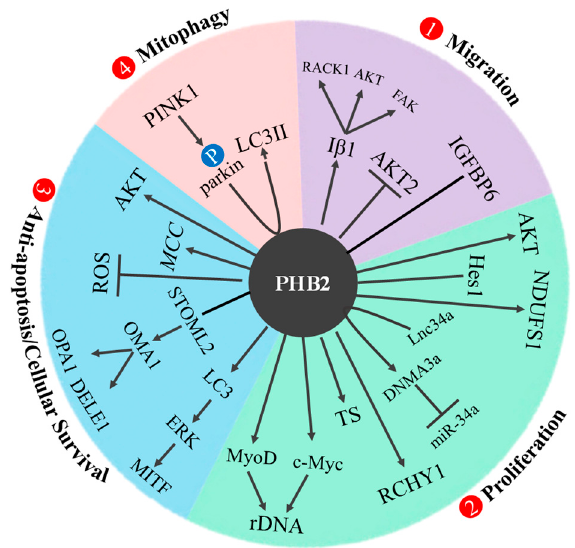
Figure 5. Schematic diagram of the multiple oncogenic mechanisms of PHB2. PHB2 has four main functions: (1) Promote migration, (2) Enhance proliferation, (3) Induce anti-apoptosis/cellular sur- vival, and (4) Initiate mitophagy. The detailed PHB2 functions in di ff erent cancers were further de- survival, and (4) Initiate mitophagy. The detailed PHB2 functions in different cancers were further scribed in Table 1. described in Table